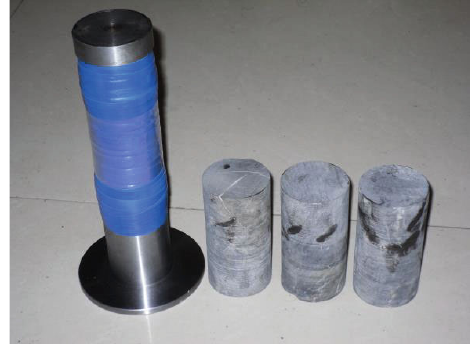
Figure 6: Postpeak rock specimen for measurement.